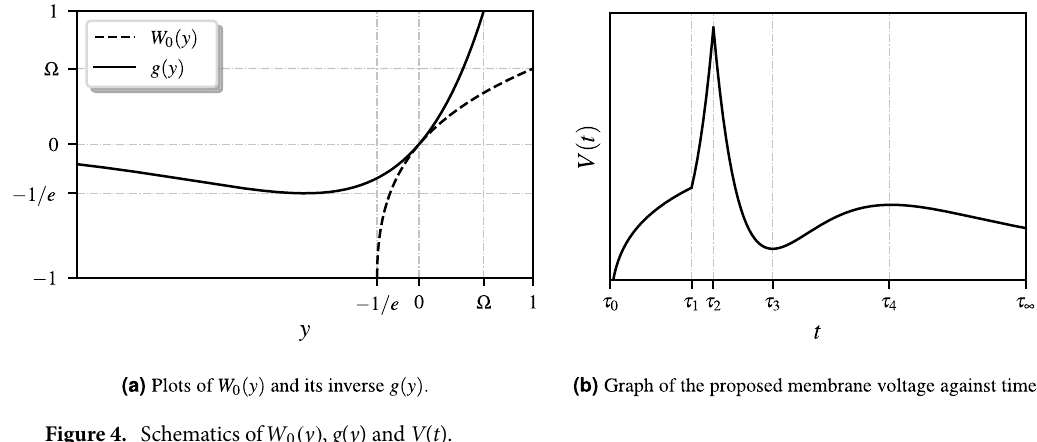
Figure 4. Schematics of W 0 ( y ) , g ( y ) and V ( t